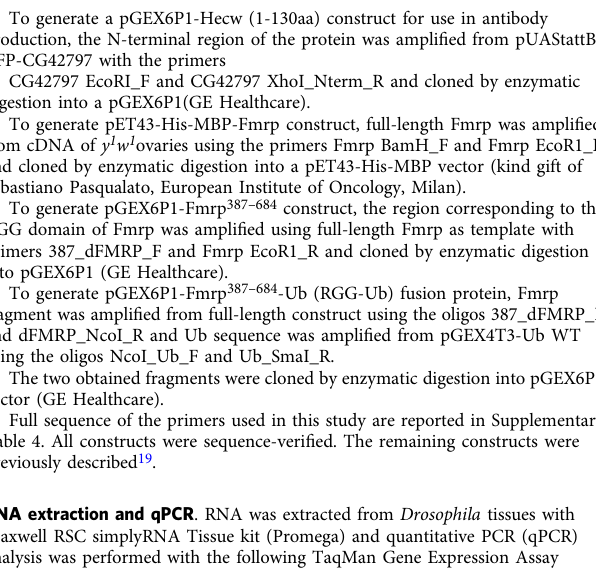
Table 4. All constructs were sequence-veri fi ed. The remaining constructs were previously described 19 . RNA extraction and qPCR . RNA was extracted from Drosophila tissues with Maxwell RSC simplyRNA Tissue kit (Promega) and quantitative PCR (qPCR) analysis was performed with the following TaqMan Gene Expression Assay (Thermo Fisher Scienti fi c): Dm01837441_g1 ( CG42797/Hecw ), Dm01841193_g1( gurken ), Dm02136373_m1( Fmr1 ), Dm02136342_g1( orb ), Dm02134538_g1